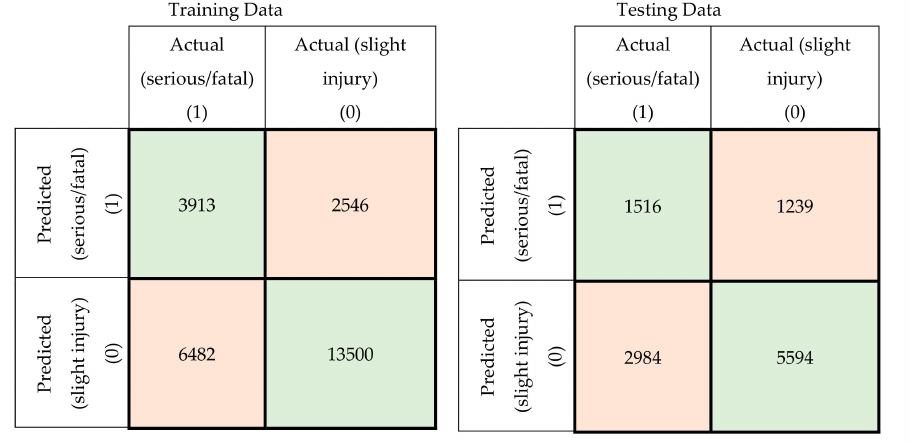
Figure 6. Confusion matrices for the SVM model using original crash attributes (training and testing